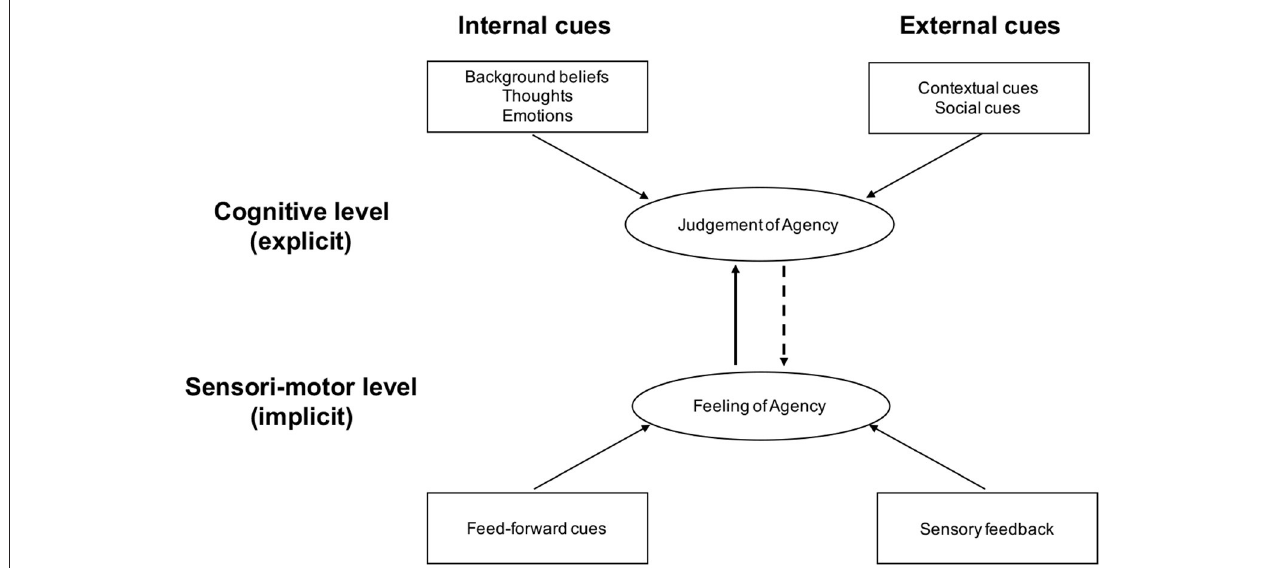
FIGURE 2 | A cue integration model of SoA [adapted from (79, 80)].